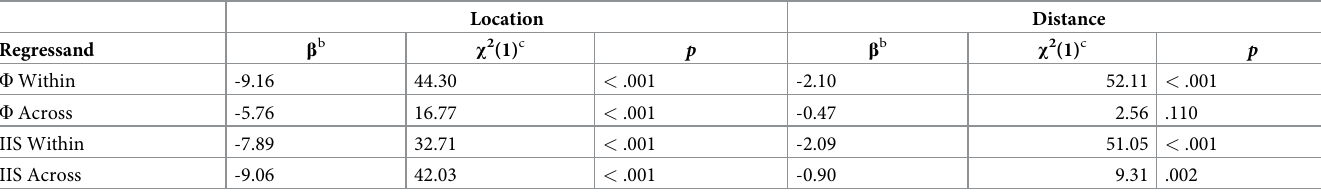
Across: across-fly classification accuracy using F . IIS Within: within-fly classification accuracy using IIS, integrated information structure. IIS Across: across-fly classification accuracy using IIS. Location: average location of channels in a channel set. Distance: sum of pairwise distances between channels within a channel